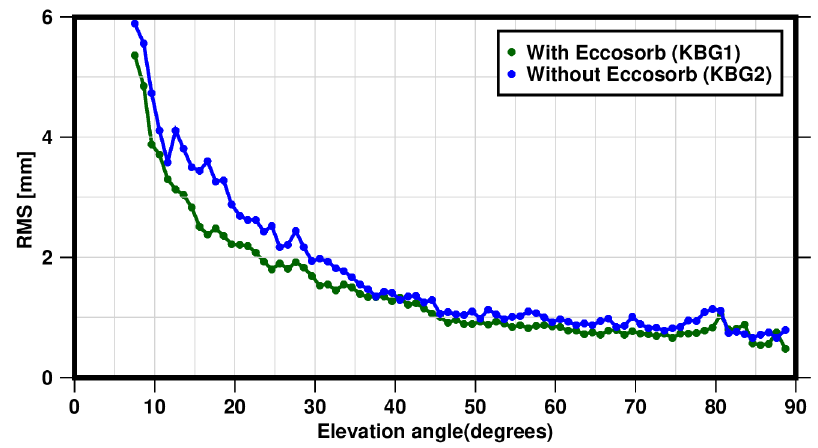
Figure 10. The RMS values of the post-fit carrier phase residuals (LC) of the L1 and L2 phase observables for station BKG1 with the microwave absorber in blue solid colour and for station BKG2 in dark green solid colour for elevation angles with a bin width of 1 ◦